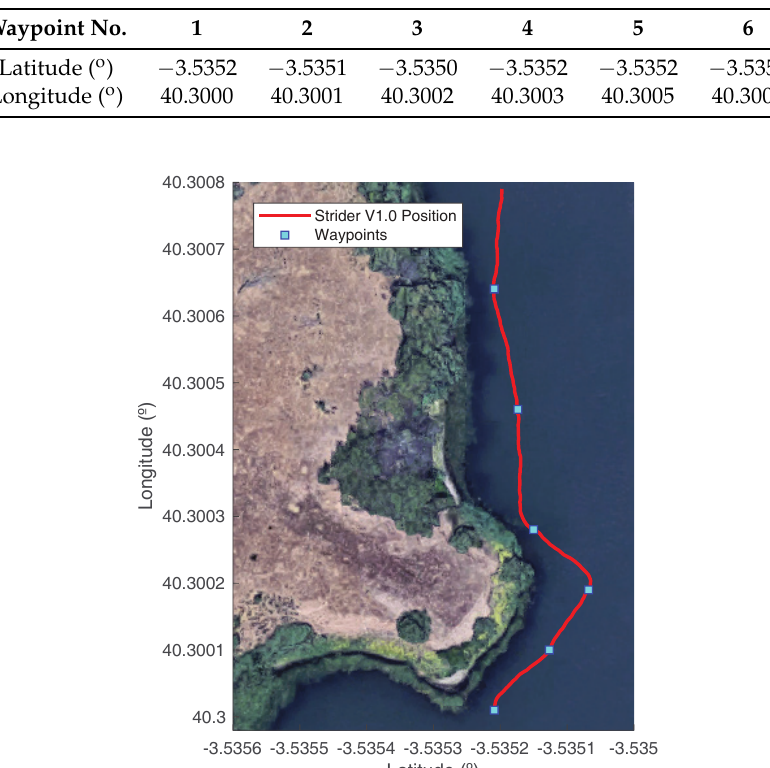
Table 2. Ordered waypoint vector with latitude and longitude coordinates.